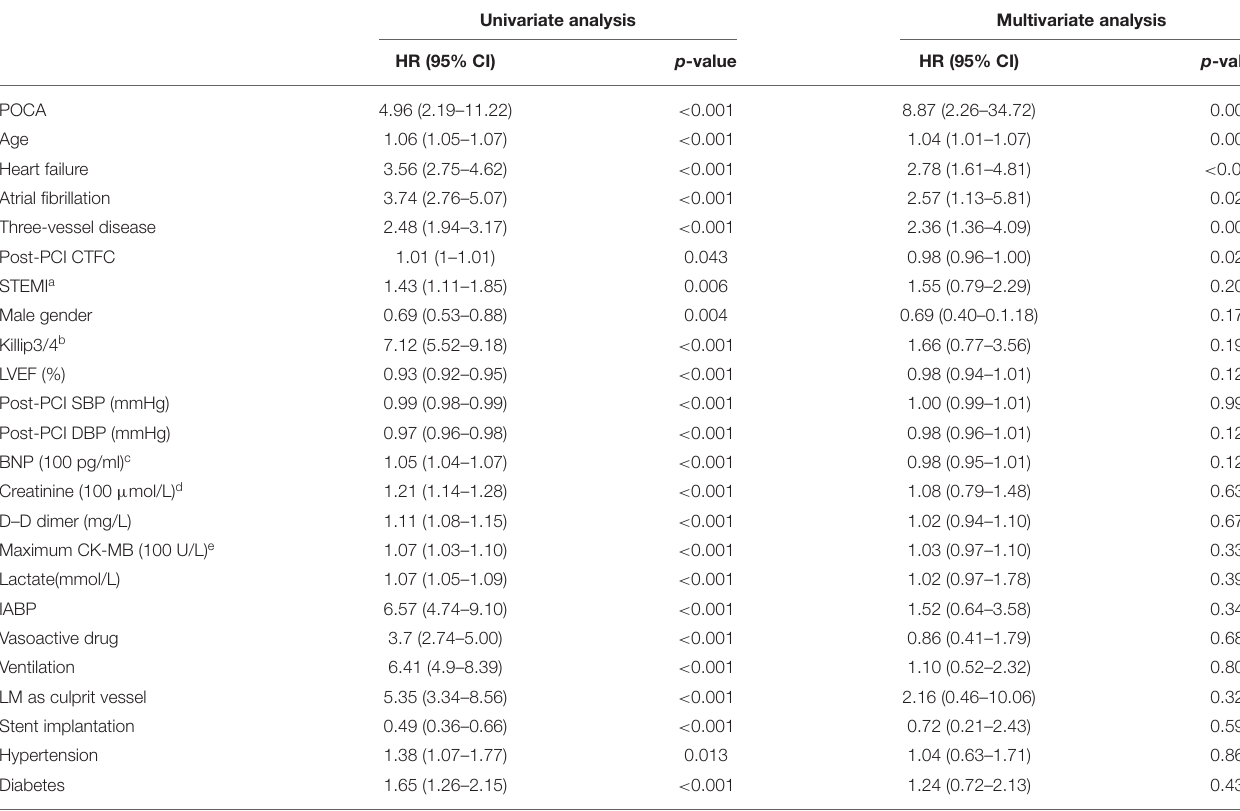
TABLE 5 | Predictors of all-cause mortality in long-term mortality (day 30 to end of study). Univariate analysis Multivariate